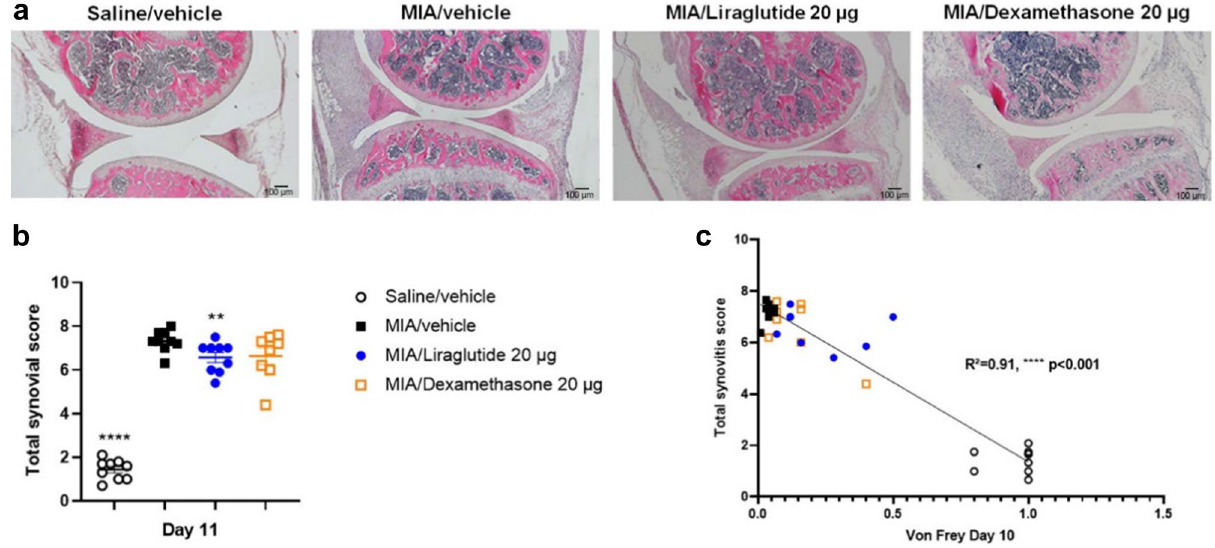
Figure 3. Liraglutide displayed anti-inflammatory effect in vivo in short-term MIA mice model of OA. Mice knee joints were intra-articularly (IA) injected with 0.75 mg of MIA or saline on day 1. Treatments (liraglutide, dexamethasone, or vehicle) were IA injected on day 3 (n = 15–19 per group). At the end of the study, on day 11, the mice were euthanized, and the right knee joint was recovered for histological analyses. ( a ) Representative photographs of sagittal sections of the paws of mice IA injected with 0.75 mg of MIA to induce inflammation and subsequently IA treated with vehicle, liraglutide or dexamethasone (positive control). ( b ) Histogram representing the total synovitis score calculated from Krenn et al . , synovitis score system (n = 8–9 per group). ( c ) Based on the results of the von Frey test on day 10 and the synovitis score obtained for each animal, a correlation curve between these two parameters was calculated using GraphPad Prism 9.0 (n = 8–9 per group). Statistical analysis: Mean ± SEM. Mann–Whitney test with sequential strategy, ** p < 0.01, **** p < 0.0001 versus MIA control. Simple linear regression, **** p <